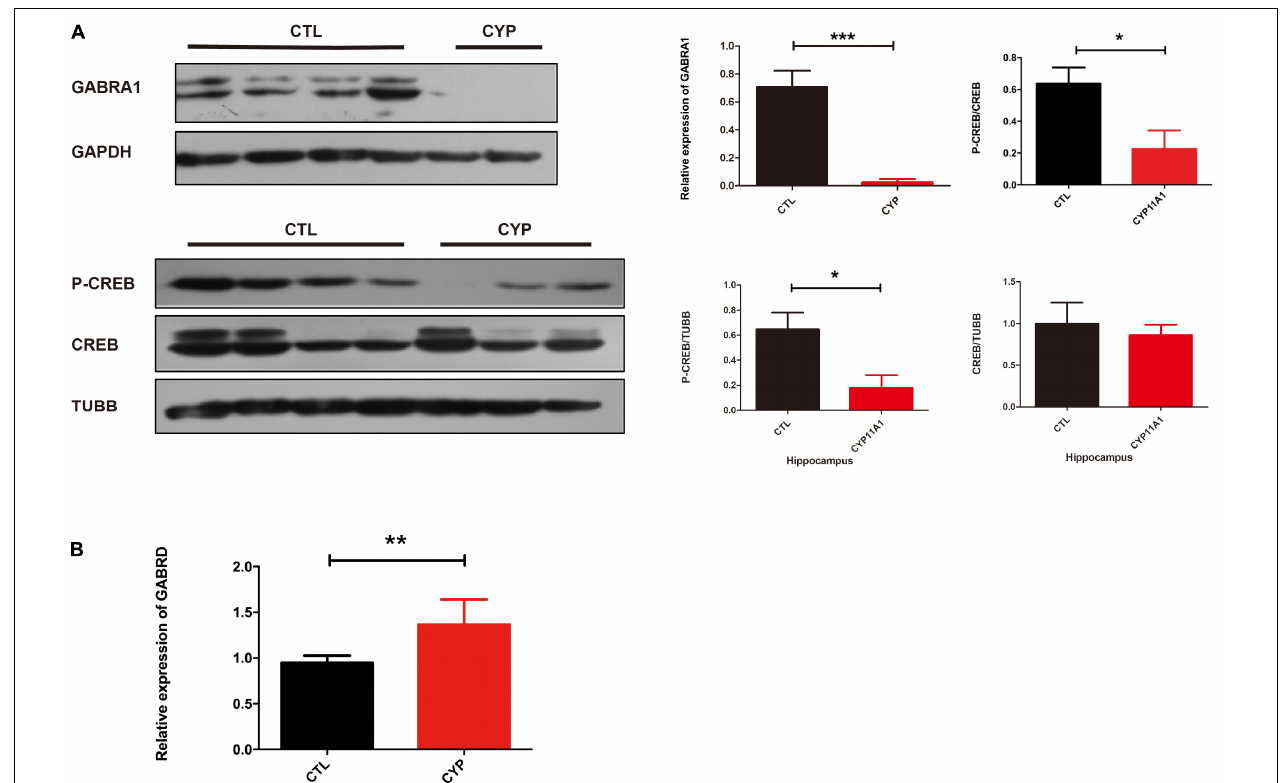
FIGURE 5 | CYP11A1 overexpression in vivo led to altered GABAA receptor expression. (A) Western blot analysis revealed that CYP11A1 overexpression induced GABRA1 expression and decreased the ratio of P-CREB to CREB in the brain hippocampus. (B) GABRD transcript expression was increased by CYP11A1 overexpression (* P < 0.05, ** P < 0.01, and *** P <